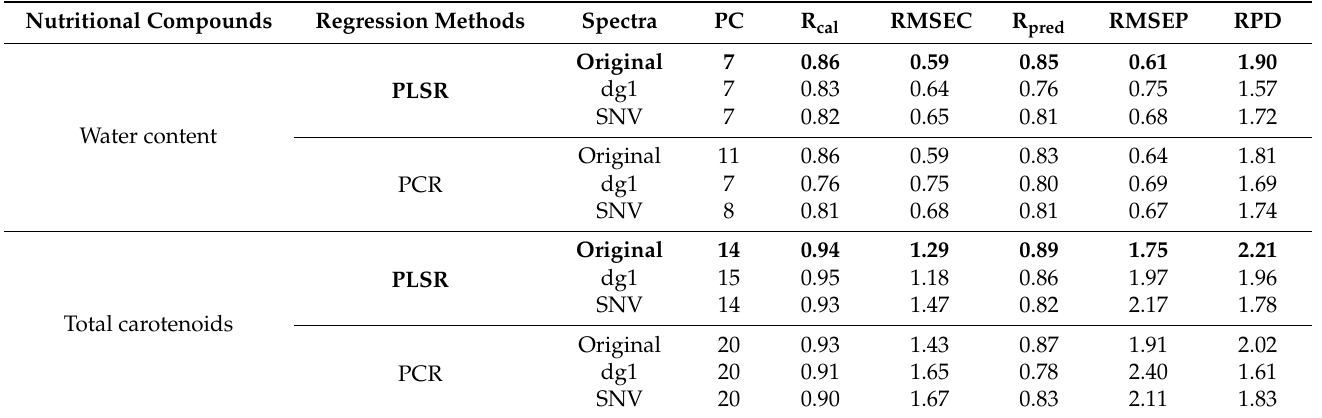
Table 2. Summary of PLSR and PCR of water content, total carotenoids, and capsaicin in calibration set and prediction